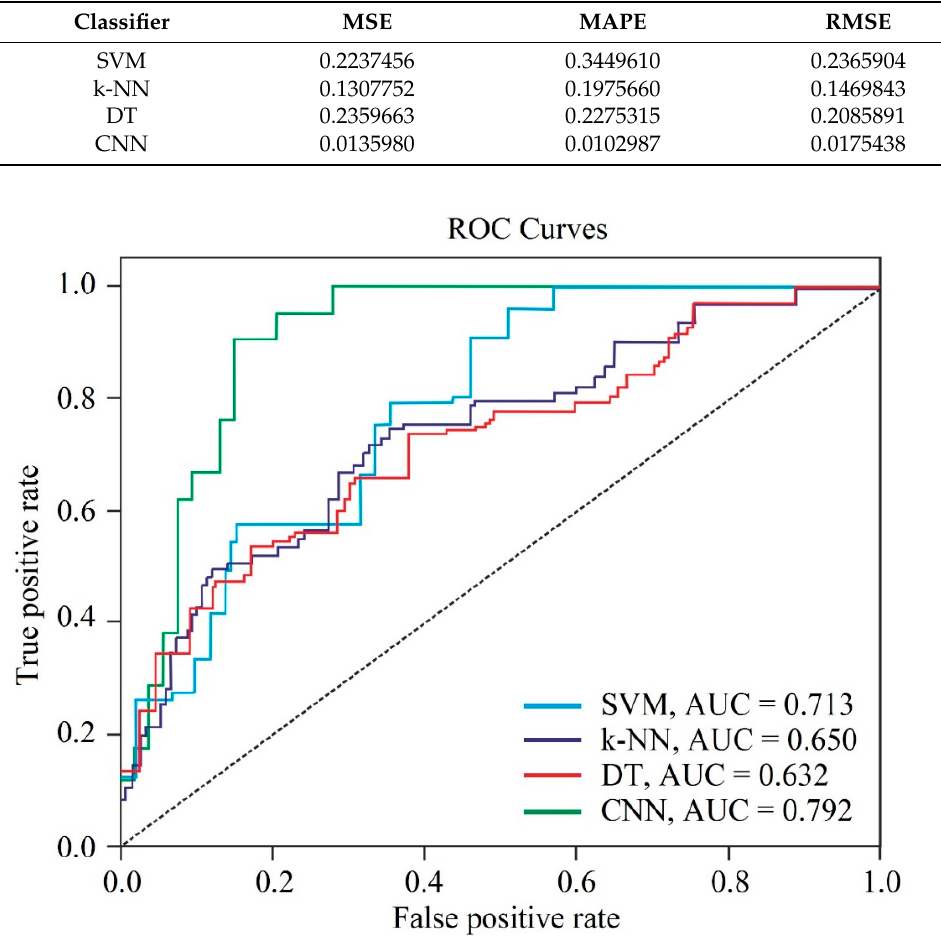
Table 5. The error table for different machine-learning modeling.